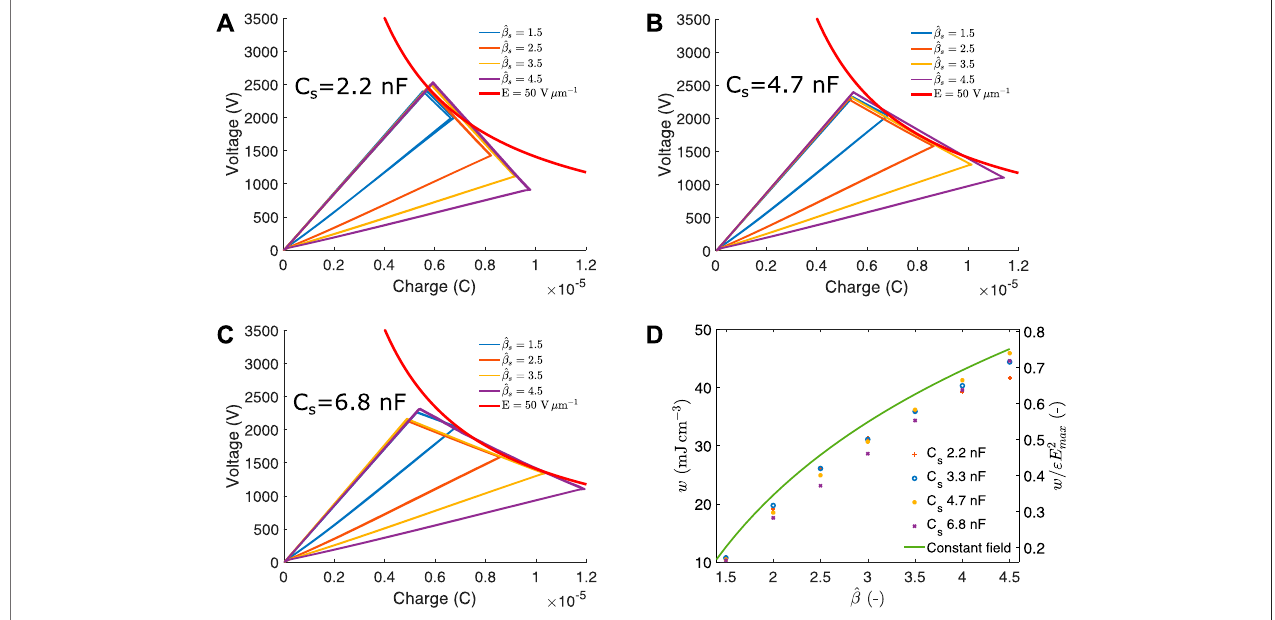
FIGURE9| Harvestingcyclesforcapacitanceswingsbetween1.5and4.5anddifferentvaluesofstoragecapacitor: (A) 2.2 nF, (B) 4.7 nF, (C) 6.8 nF. (D) average energy density and normalised energy density as a function of capacitance swing and for different values of storage capacitor. The maximal theoretical harvestable energy density as provided by the constant fi eld cycle is also indicated for